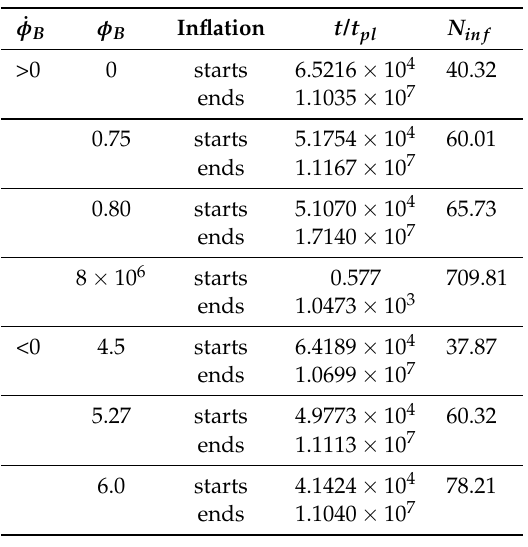
Table 1. N inf in the case of ˙ φ B > 0 and ˙ φ B <